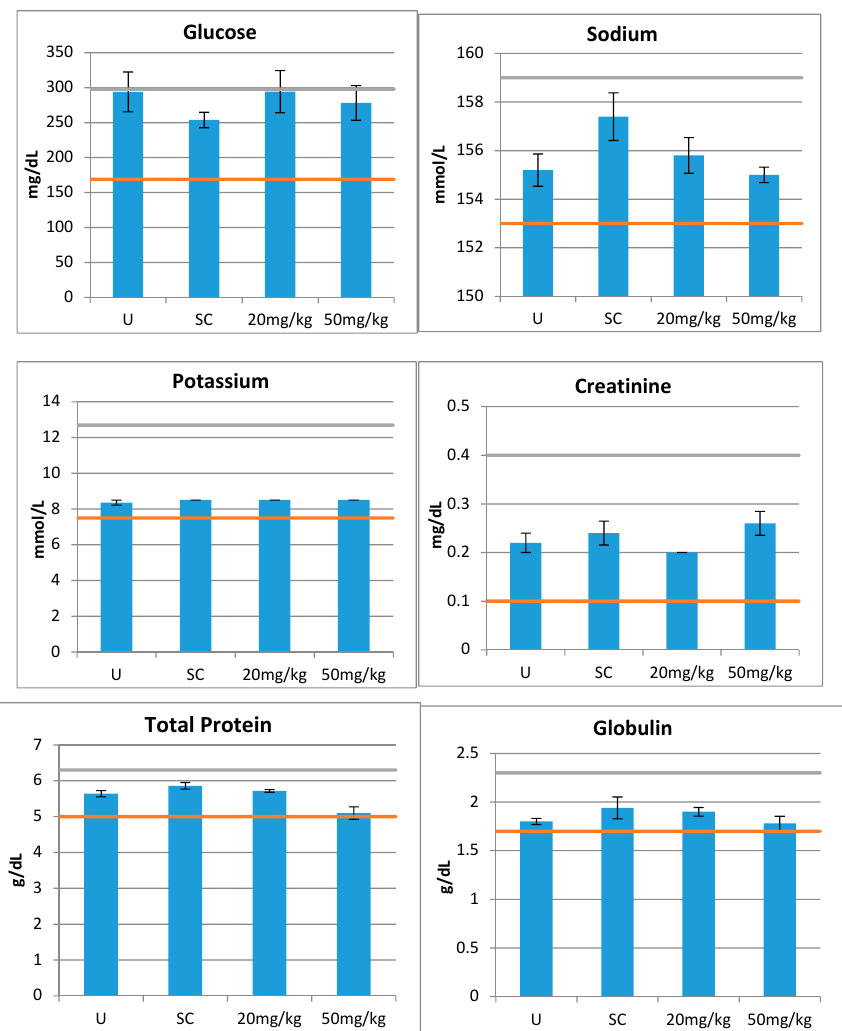
Figure 3. In vivo toxicity of compound 15 . Two doses (20 and 50 mg/kg) were administered IP in CD-1 mice ( n = 5 for each dose). Blood samples were collected 24 hours later and tested by 14 parameters for organ functions. The orange and green lines indicate the normal ranges for the assays. U = Untreated and SC = Saline Control.